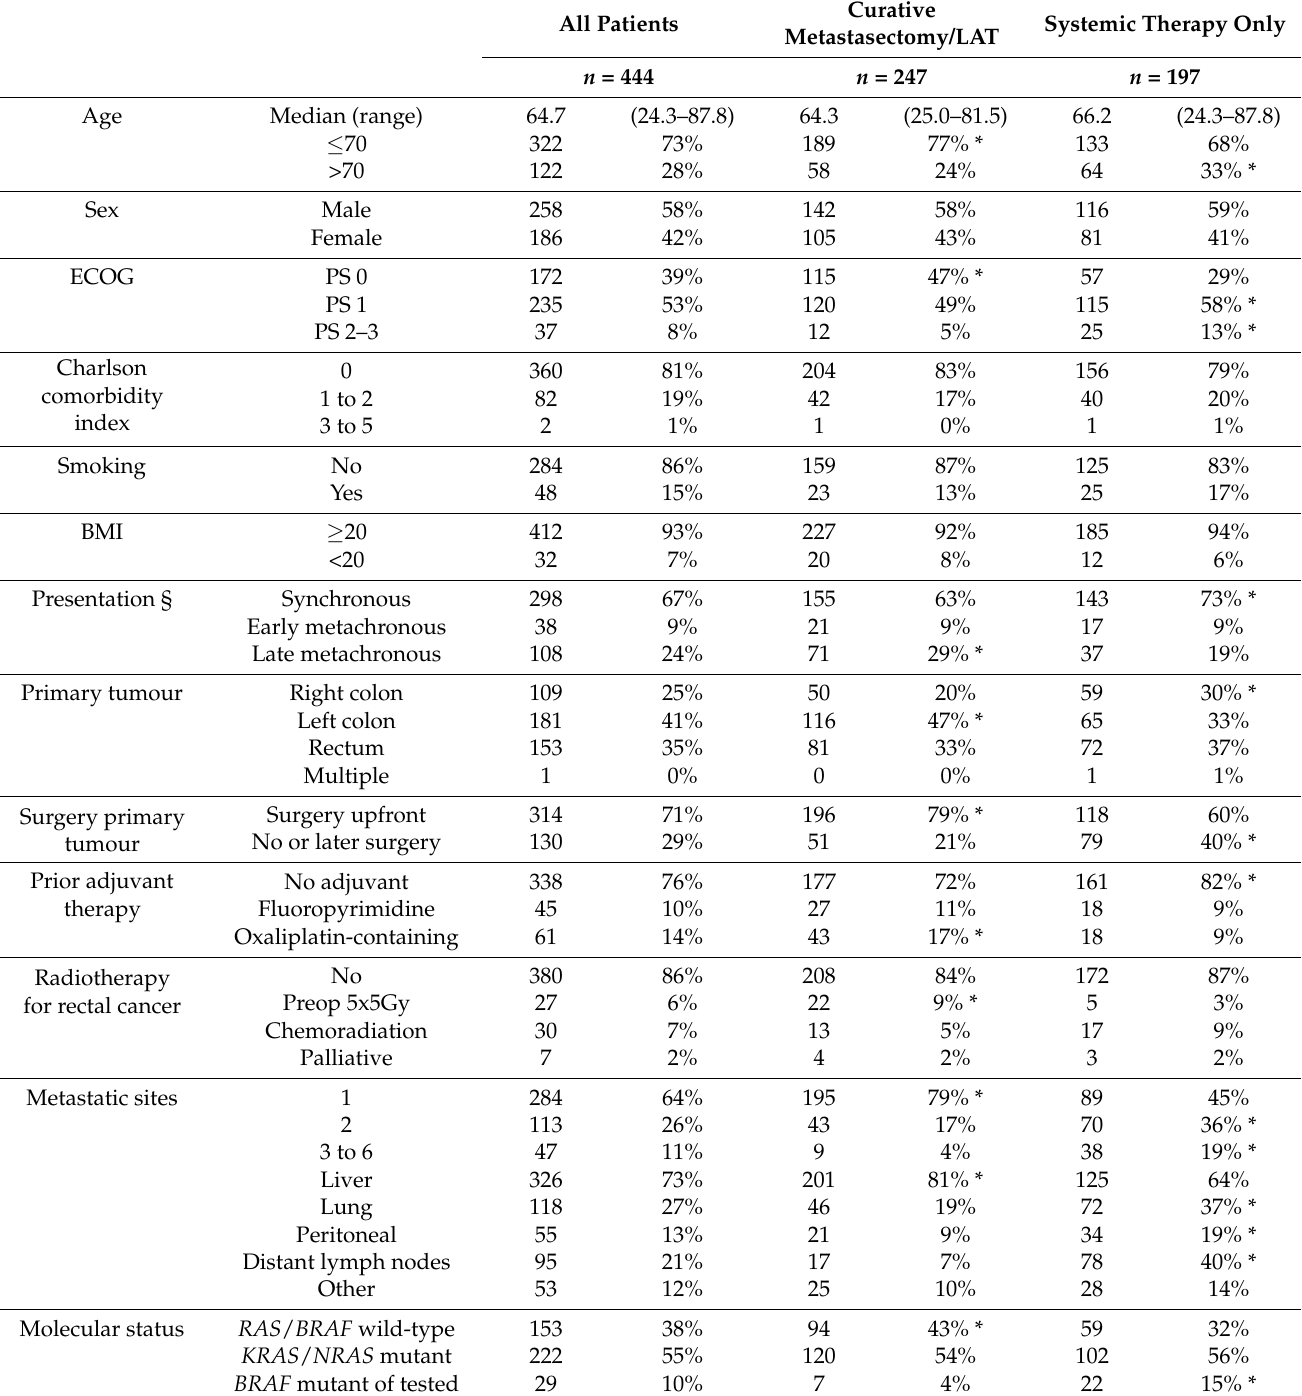
Table 1. Patient demographics according to metastasectomy and/or locally ablative therapy (LAT) performed during disease trajectory or systemic therapy only are